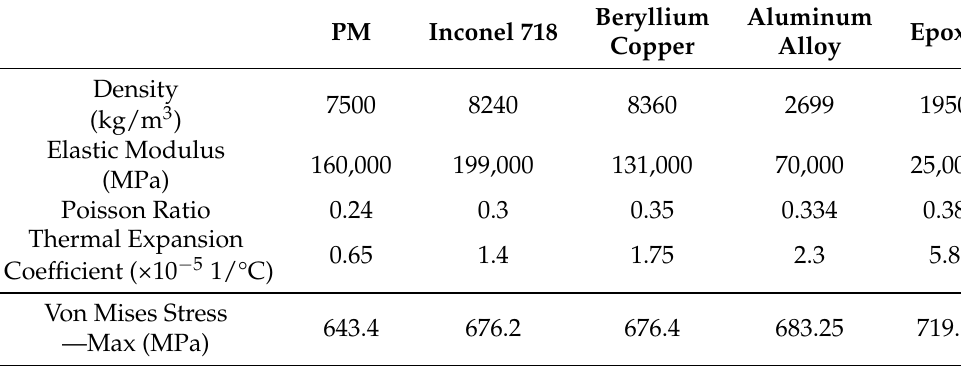
Table 3. The physical parameters of the filler.